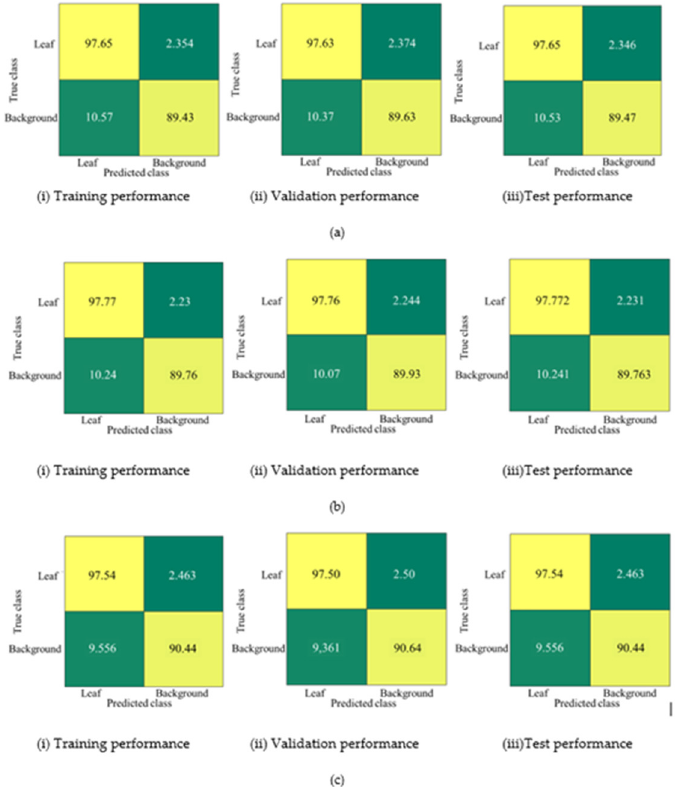
Figure A1. Confusion matrix with training, validation, and testing dataset: ( a ) Deeplabv3plusXceptionNet; (b) Deeplabv3plusResNet50; (c) Deeplabv3plusMobileNetv2.